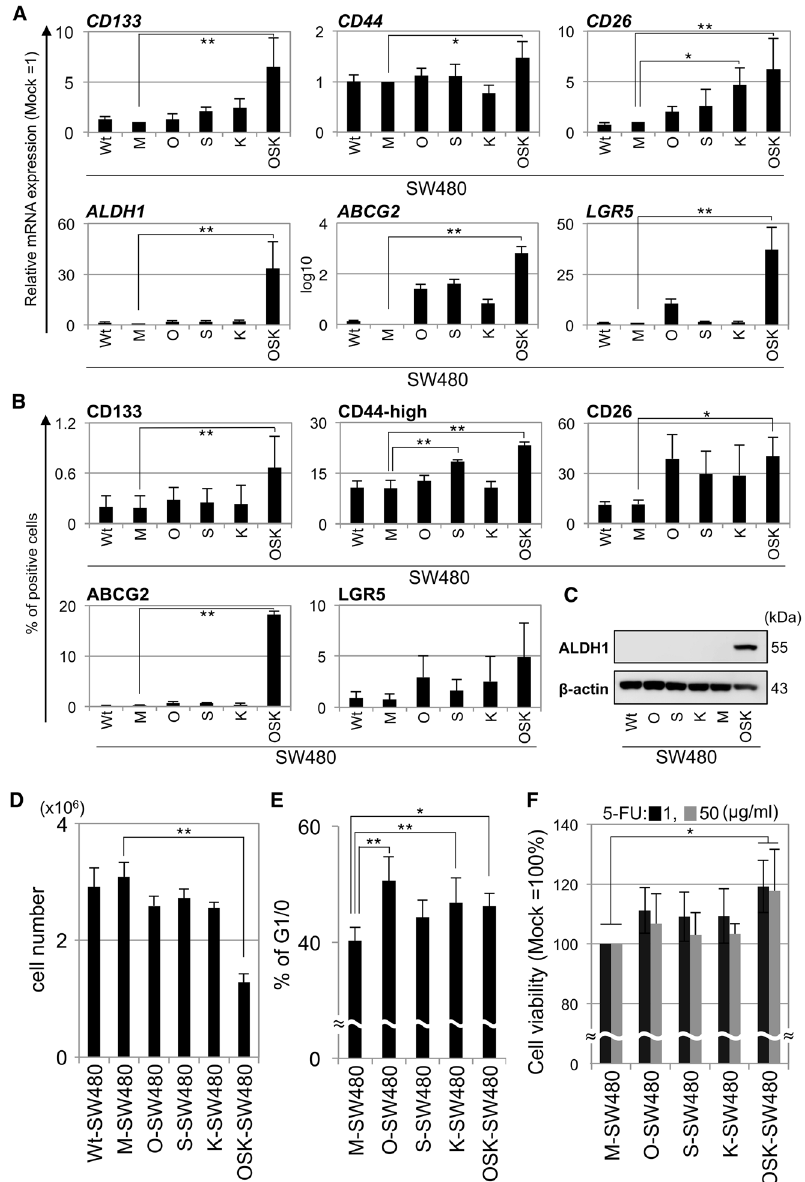
Figure 1. The transduction of OSK induced CSC properties in SW480 cells invitro . (A) qRT-PCR of previously reported markers related to colon CSCs and intestinal stem cells in the transduced SW480 cells. All the markers were upregulated in the OSK-SW480 cells. The mRNA expression levels were normalized to those of GAPDH . The relative expression levels compared to those of M-SW480 are shown. (B) The protein expression levels of CSC markers in the transduced SW480 cells as determined by a flow cytometric (FCM) analysis. The data from three independent experiments demonstrated that the numbers of CD133-, CD44-high-, CD26- and ABCG2-positive cells were significantly increased in the OSK-SW480 cells. The representative dot plots of each marker are shown in Figure S2. (C) The protein expression of ALDH1 in the transduced SW480 cells determined by a Western blot analysis. The panel shows representative data from three independent experiments. (D) The cell proliferation in vitro . A total of 3 6 10 5 cells were plated on six-well plates on day seven and were counted on day 11. The number of OSK-SW480 cells was lower than that of M-SW480 cells (n=3). (E) The cells in the G1/0 phase were detected by a FCM analysis on day 11. The percentage of cells in the G1/0 phase significantly increased in the O-, K- and OSK-SW480 cells (n=3). (F) 5-FU-chemoresitance analysis. The viability of OSK-SW480 cells in the presence of 5-FU was significantly higher than that of M-SW480 cells at both the 1 and 50 m g/ml concentrations of 5-FU (n=3). The viability of the M-SW480 cells at each concentration was set to 100%. The error bars indicate the standard deviation: SD. *P , 0.05, **P , 0.01, Dunnett’s